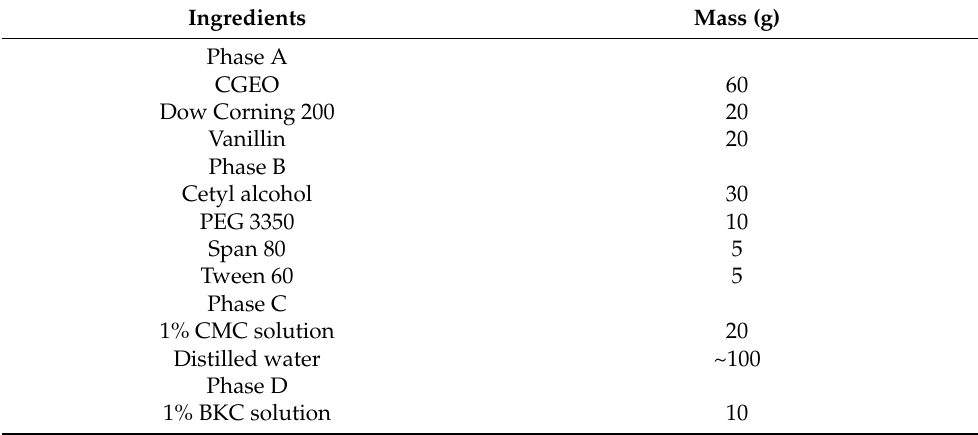
Figure 5. Schematic representation of the microencapsulation process of the Citrus grandis essential oil (CGEO). Table 1. Composition of the encapsulation